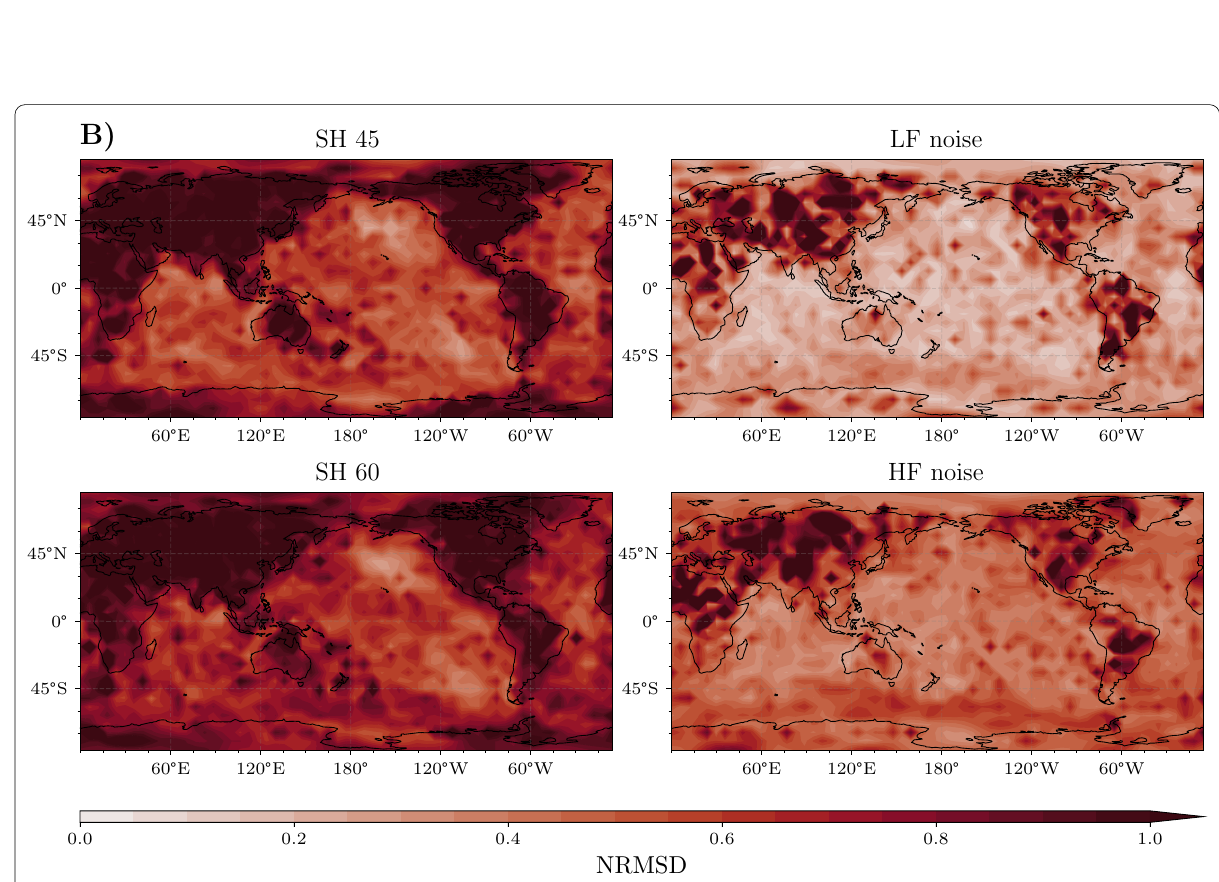
Fig. 10 The assimilation results using various from the imposed field differing true OIMFs. The shown NRMSD expresses how well the rescaled OIMF anomalies reflects the true OIMF anomalies. The left side shows the result for spatial deviations using a true OIMF with SH resolution of degrees 45 and 60. On the right side, temporal deviations in the form of low‑frequency (LF) and high‑frequency (HF) noise are considered. Dark red indicates areas with large NRMSD and, therefore, a large discrepancy between rescaled and true OIMF; respectively, lighter colors point out areas of good